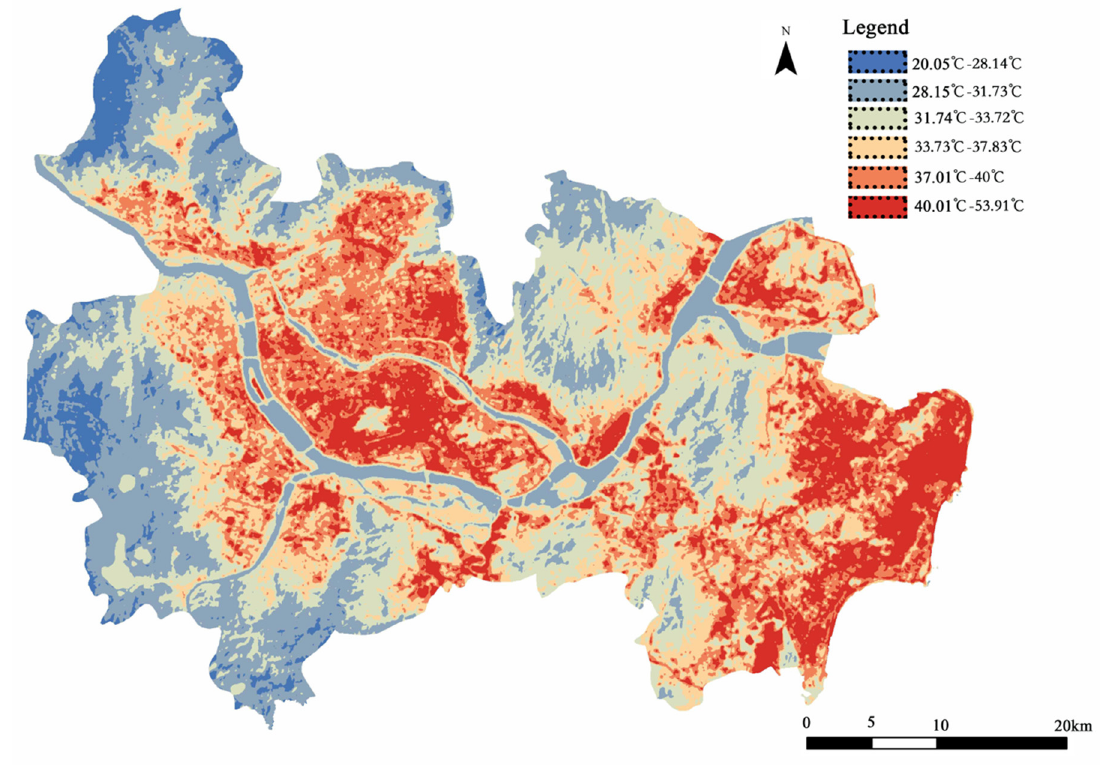
Figure 2. Surface temperature.